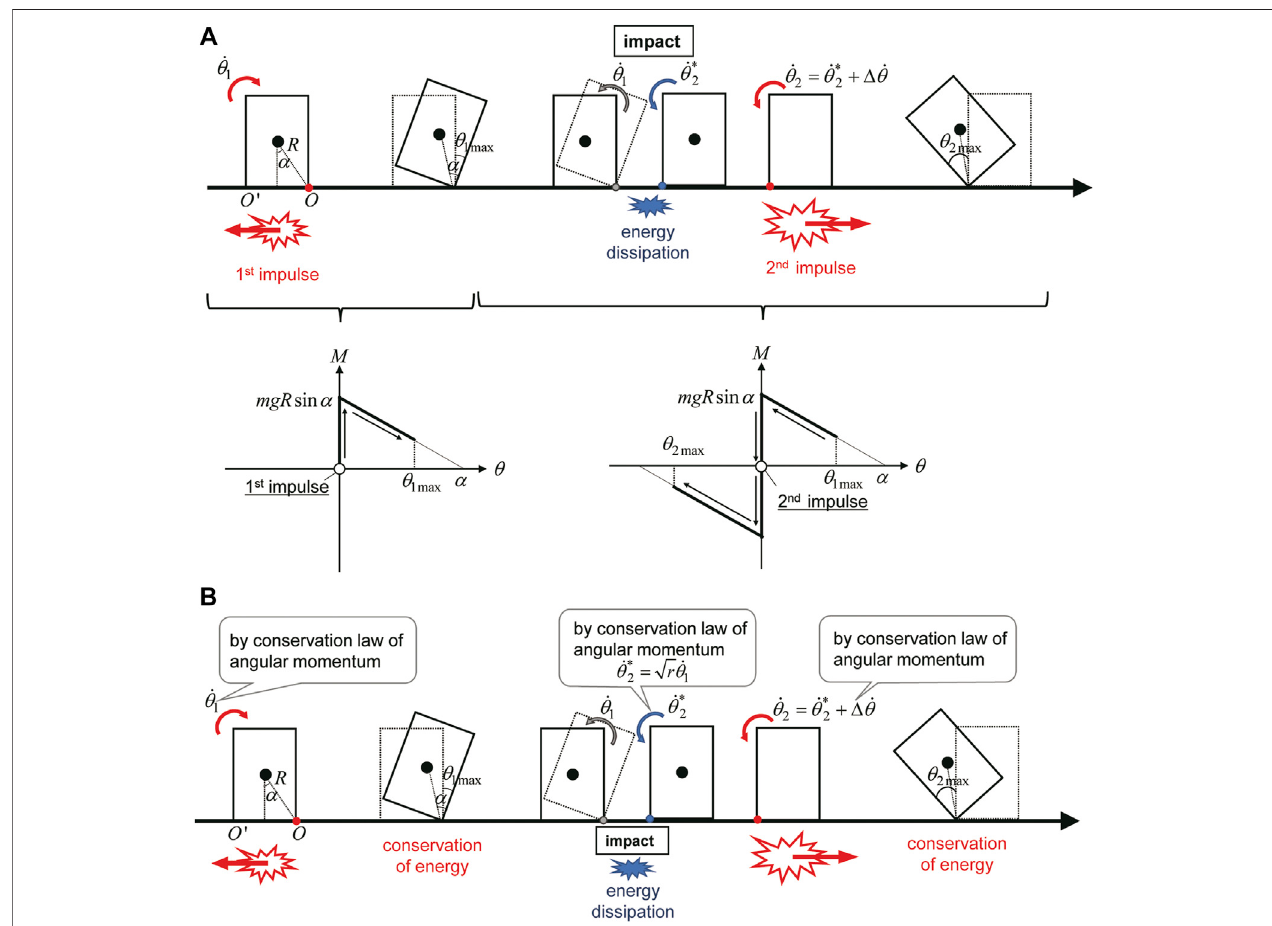
FIGURE 6 | Overview of rocking vibration under pseudo-triple impulse, consisting of the fi rst two impulses in triple impulse, (A) Overview of rocking vibration, (B) Mechanical energy conservation and angular momentum conservation.